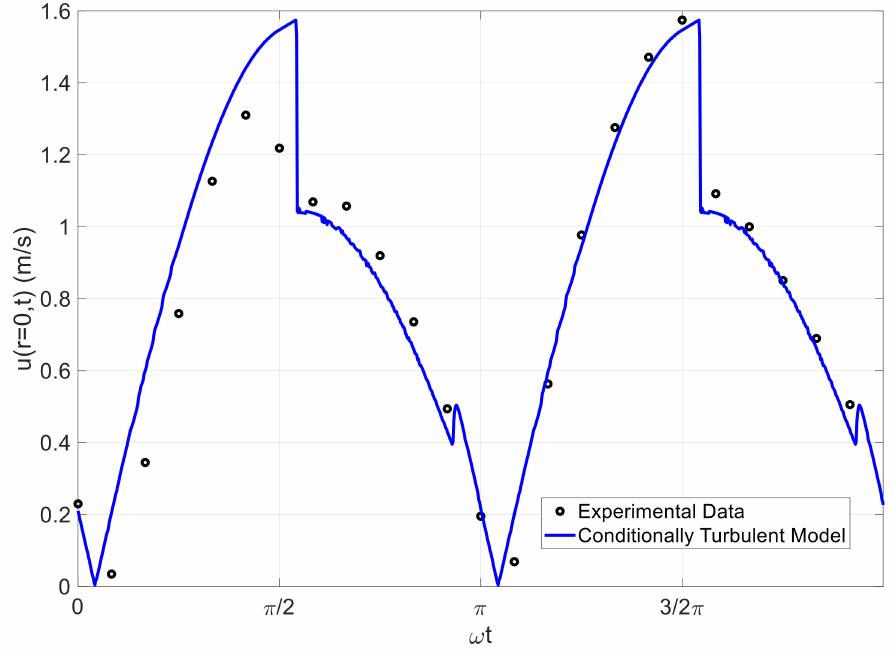
Figure 6. Comparison between the conditionally turbulent model and the experimental data for phase-averaged velocity at the pipe centerline ( r / a = 0) for Case 1: Re os = 5830, α =